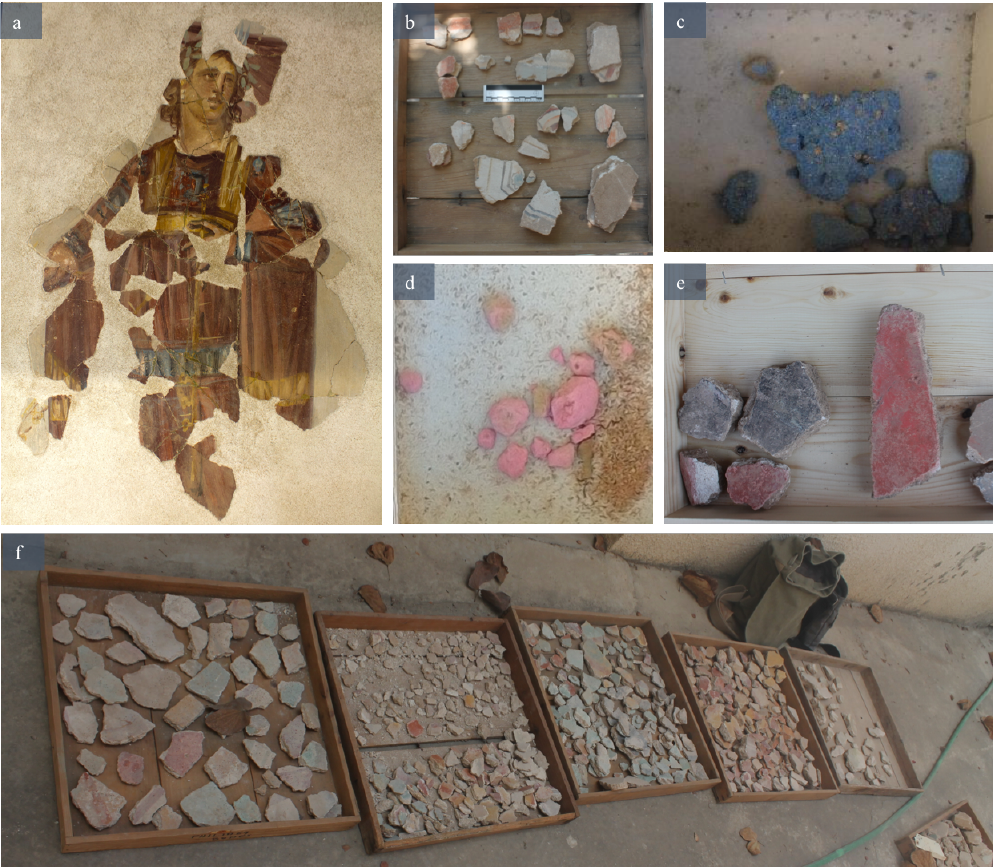
Figure 4. Examples of figurative paintings, colored fragments, and pigment pellets excavated from the residences of Nea Paphos, designated now as the Paphos Archaeological Park: ( a ) figurative painting E9, from the House of Aion; ( b ) fragments from House of the Four Seasons; ( c ) Egyptian blue pellets;